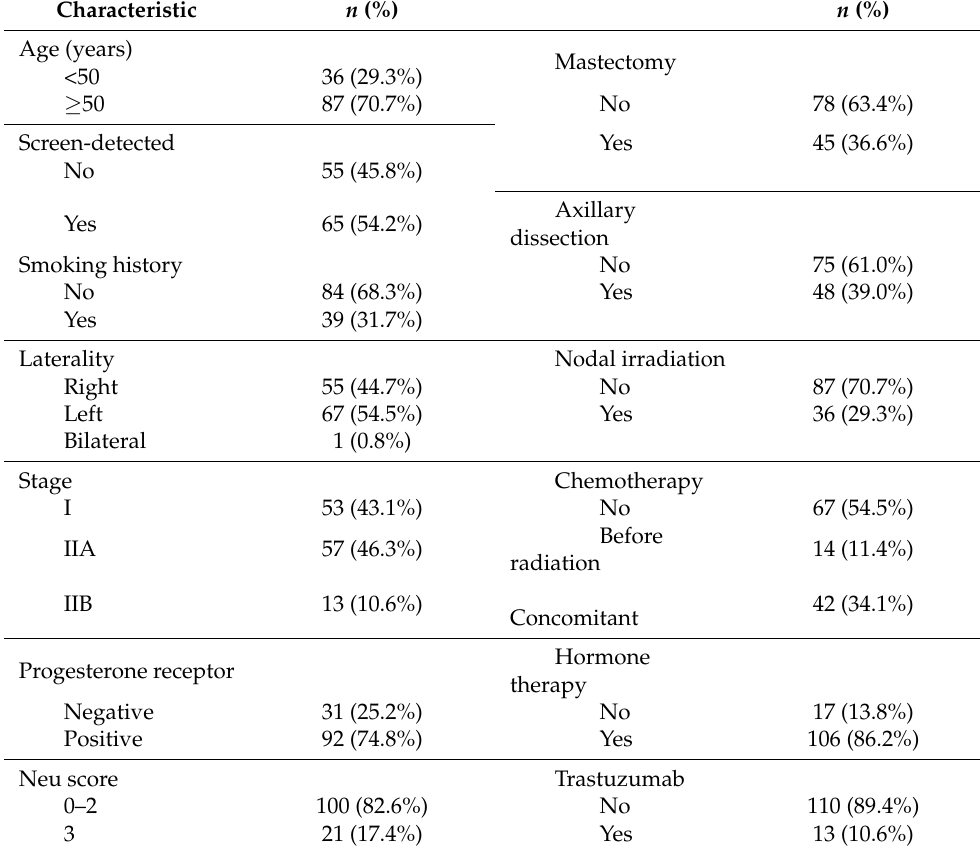
Table 1. Patient characteristics, n =